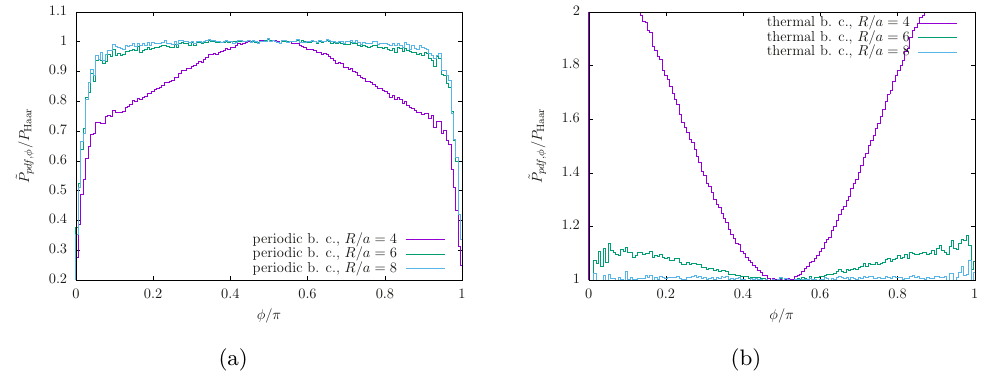
Figure 10 . Symmetrized per-site distribution of the Polyakov phase φ normalized with respect to the Haar measure for different R/a . The histogram has been determined the same runs as